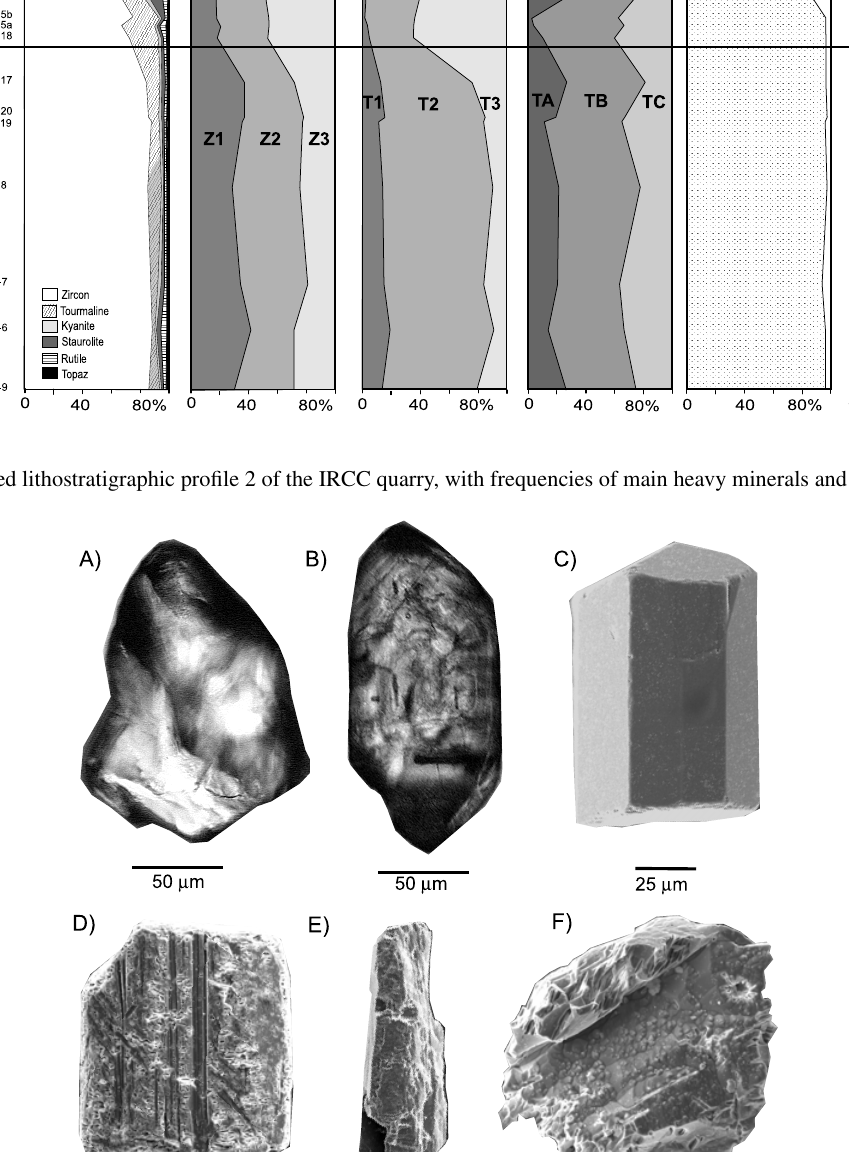
An Acad Bras Cienc (2007) 79